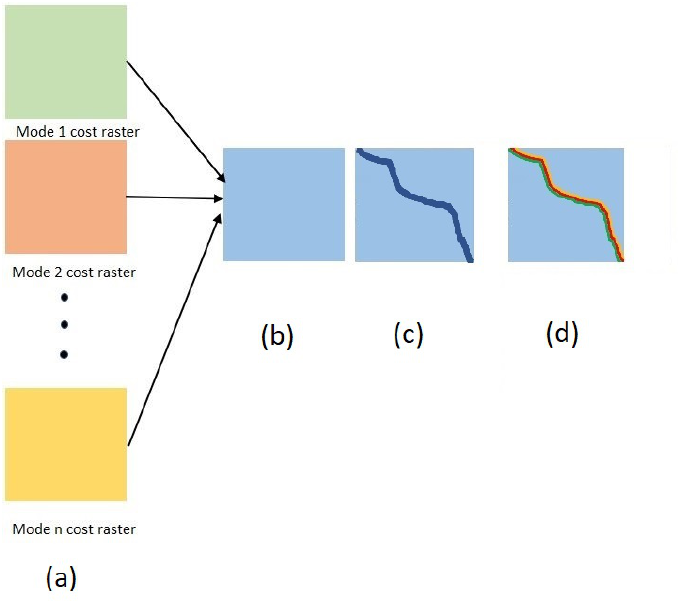
Figure 1. Finding a Wide LCP on the accumulated cost raster (FWLA) method. Subfigure ( a ) shows cost rasters for n different modes. Subfigure ( b ) illustrates the composite cost raster created for all modes. In subfigure ( c ), the wide LCP on the composite cost raster is found. In subfigure ( d ), the desired arrangement of modes is fitted into the wide LCP